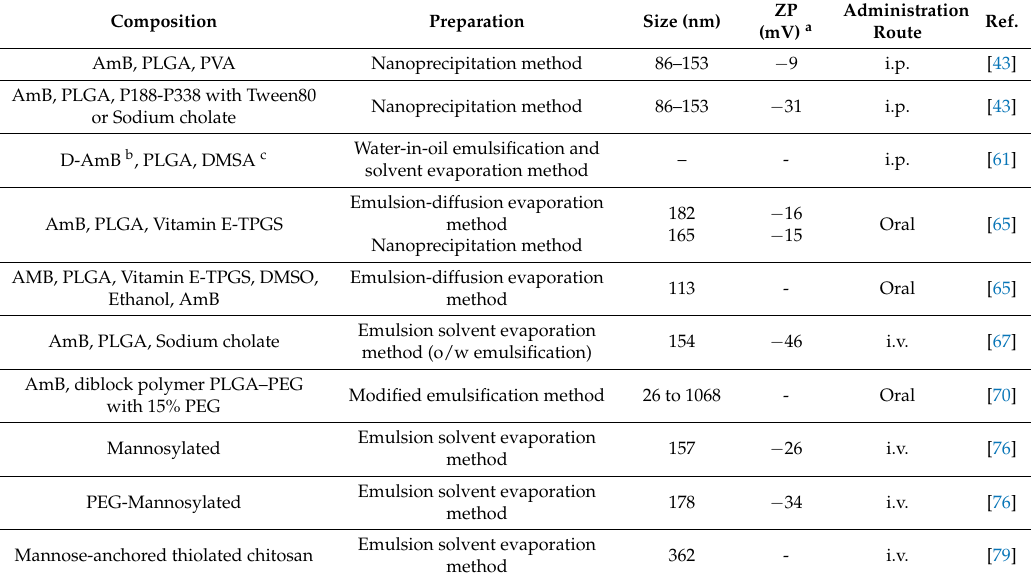
Table 2. Main features of